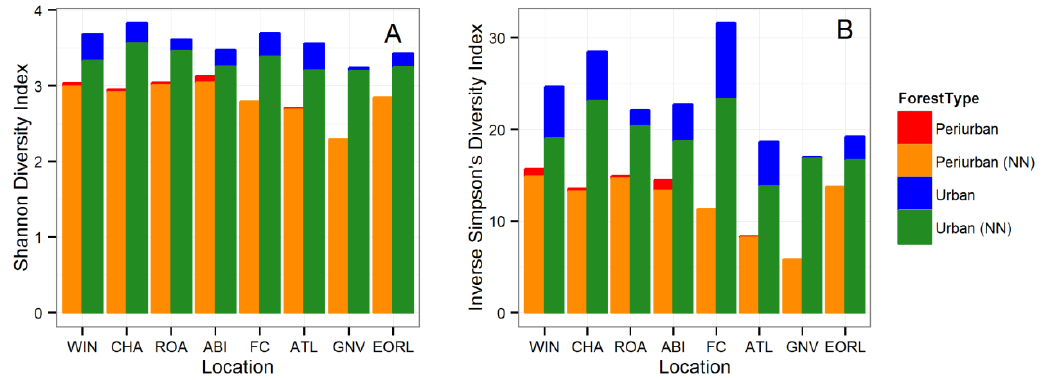
Figure 4. Diversity by location and forest type based on stem counts as defined by ( A ) Shannon Index and ( B ) Inverse Simpson’s Index. Diversity indices for all species were overlaid with diversity indices including only the native and naturalized species; secondary colors (orange and green) represent native and naturalized species diversity, primary colors (red and blue) plus secondary colors represent diversity for all species. Locations are listed North-South, with the exception of Falls Church which is listed more southerly to reflect its ecological province. (ATL = Atlanta, GA; CHA = Charlottesville, VA; EORL = East Orlando, FL; FC = Falls Church, VA; GNV = Gainesville, FL; ROA = Roanoke, VA; ABI = Abingdon, VA; WIN = Winchester, VA, NN = Native and Naturalized).